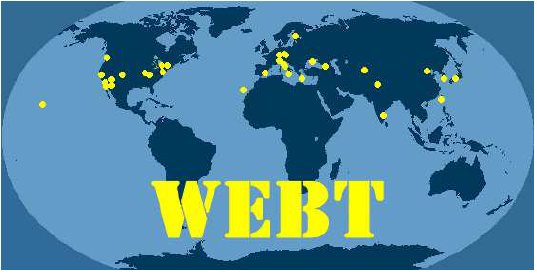
Figure 1. The WEBT collaboration logo, showing the longitude distribution of the